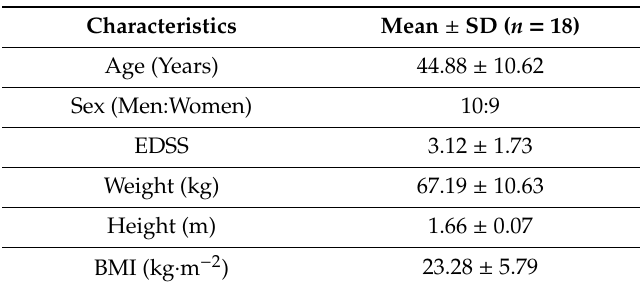
Table 1. Participant